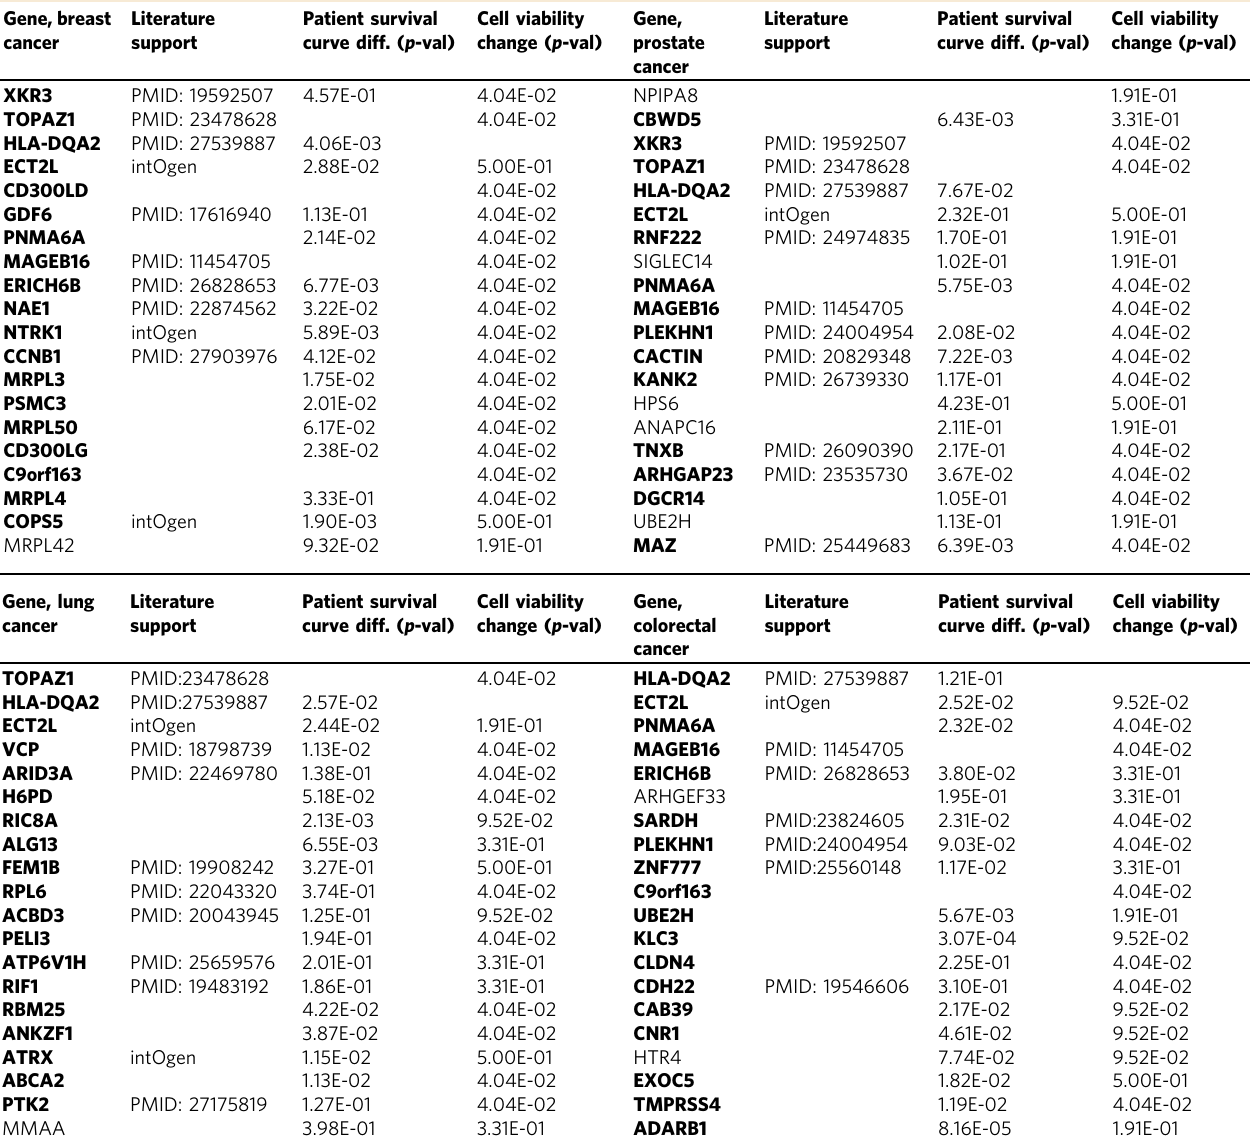
Table 1 Validation of the iCell rewired genes Gene, breast Literature cancer support